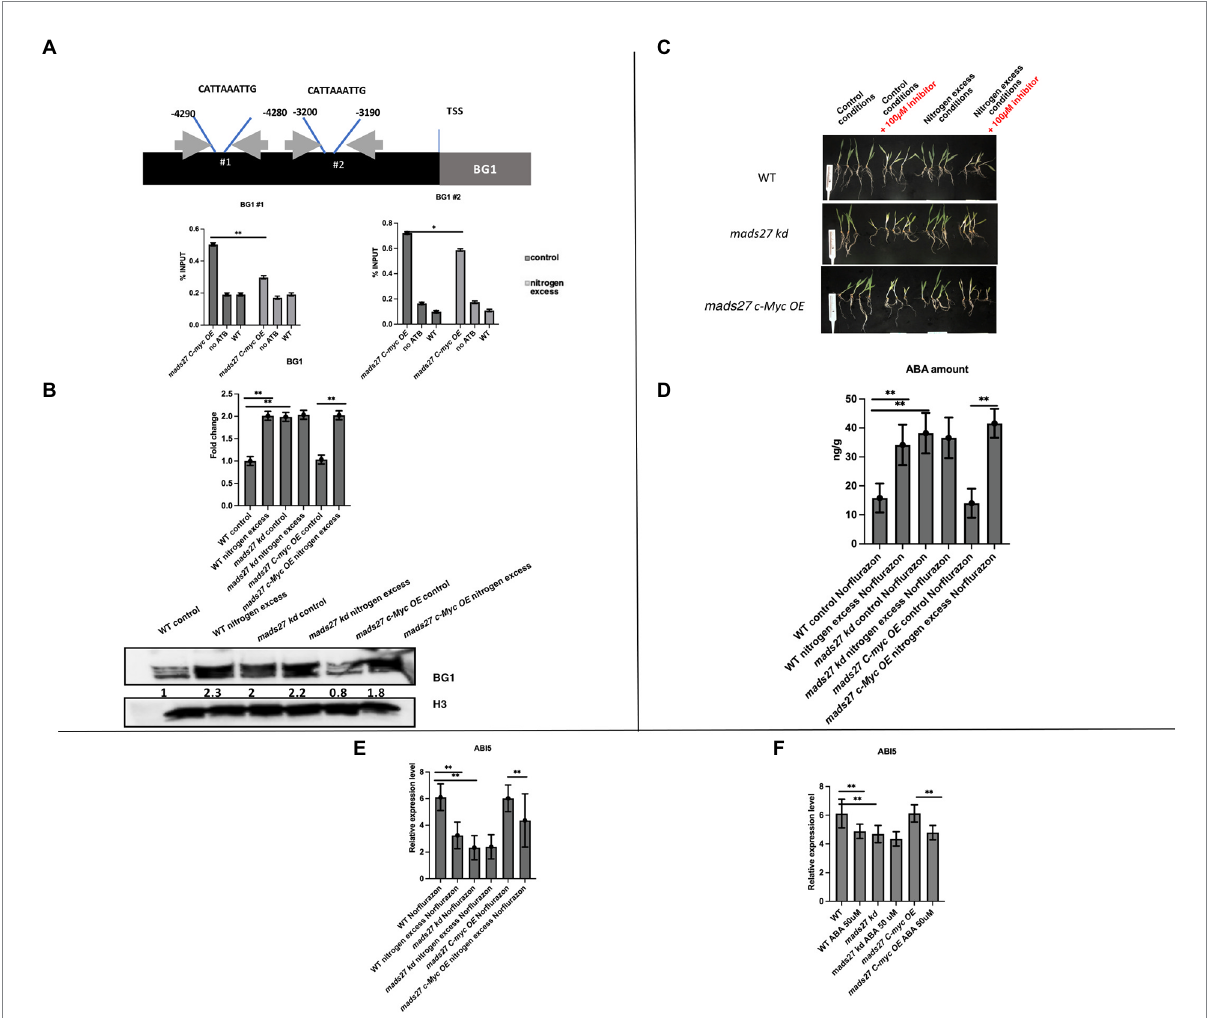
FIGURE 6 HvMADS27 transcription factor regulates expression of BG1 β -GLUCOSIDASE in barley roots. (A) Upper panel shows position of CArG motifs in HvBG1 promoter, gray box indicates gene body, while black box indicates promoter sequence, blue lines flank the position of CArG motifs. Exact position of motif was identified by counting the number of nucleotides downstream of transcription start site. Gray arrows indicate the location of primers flanking CArG motifs. Lower panel presents the results of ChIP RT-qPCR of the roots of mads27 c-Myc OE plants under control and excess N stress conditions is presented using a graph. Accumulation of HvMADS27 on HvBG1 promoter both in control and excess N conditions with lower occupation observed in stress. (B) Upper panel shows RT-qPCR results. There was an increase in the expression of HvBG1 mRNA in the roots of WT and mads27 c-Myc OE lines under excess N stress, whereas HvBG1 mRNA expression was high in the roots of mads27 kd mutant under control conditions and was not significantly affected by excess N stress. Lower panel shows western blot analysis of HvBG1 protein level in WT and mutant lines under control and excess N conditions. There was an increase in HvBG1 protein expression in the roots of mads27 kd mutant under both control and excess N conditions, whereas HvBG1 protein expression was increased in the roots of mads27 c-Myc OE mutant only under excess N stress. Below HvBG1 signal densitometric analysis is provided. HvBG1 level was validated using HvBG1 signal from roots of WT plants grown under control conditions. Signal from histon HvH3 was used as a loading control. (C) WT, mads27 kd , and mads27 c-Myc OE mutants plants grown under control and excess N stress conditions (supplemented with Norflurazon). Plants from mads27 kd #3 line and mads27 c-Myc OE #4 were used for the experiment. (D) The ABA content of the roots of WT and mads27 kd, mads27 c-Myc OE lines grown under control and excess N conditions (supplemented with Norflurazon) was determined by high-pressure liquid chromatography technique. There was an increase in the ABA concentration of Norflurazon-treated roots of WT, mads27 kd , and mads27 c-Myc OE plants under excess N stress, while in the case of mads27 kd ABA was high both under control and excess N stress conditions. (E) RT-qPCR results showing expression profiles of HvABI5 mRNA in WT, mads27 kd , and mads27 c-Myc OE lines under control and excess N stress conditions supplemented with Norflurazon. HvABI5 mRNA expression was significantly downregulated in the roots of WT and mads27 c-Myc OE lines under excess N, whereas the HvAB15 mRNA was significantly lower in the root of mads27 kd mutants under both control and excess N stress conditions. (F) RT-qPCR results showing HvABI5 mRNA level in WT and analyzed mutants in control and N excess conditions. Expression of HvABI5 is downregulated upon ABA stress when compared to control conditions in WT plants, mads27 c-Myc OE plants. In mads27 kd plants the level of HvABI5 is not changed upon the stress. (E,F) x -axis presents analyzed variants and y -axis expression level relative to ARF 1 mRNA. (A,B,D–F) Statistical significance based on Student’s t -test, * p < 0.05, ** p <